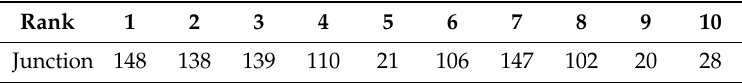
Table 13. Results of sensitivity analysis for test bed.